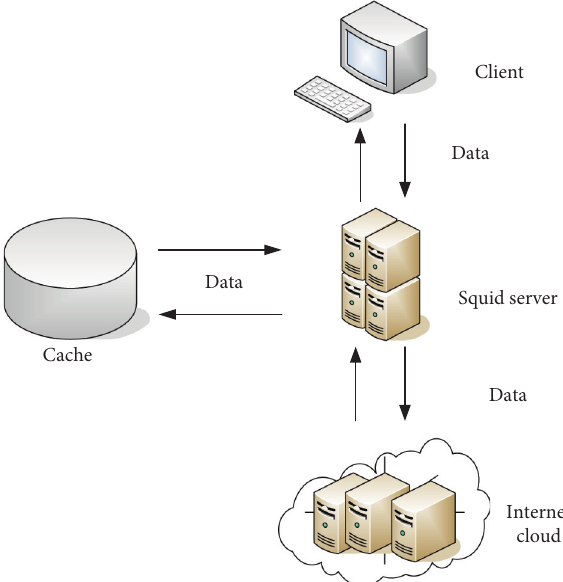
Figure 4: Squid’s working